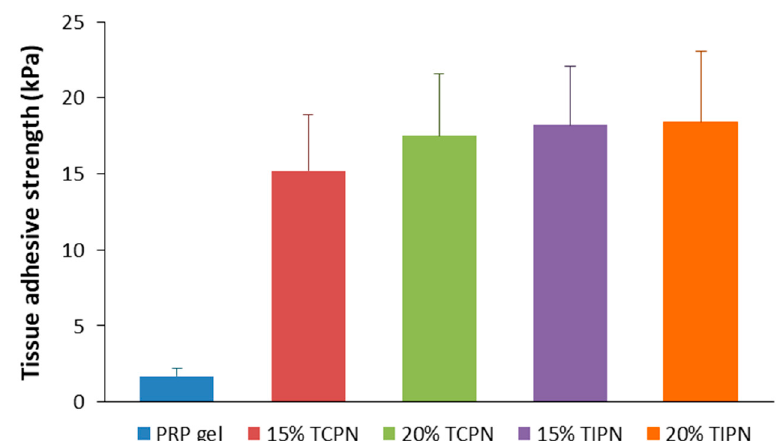
Figure 7. Tissue adhesive strength of PRP gel compared to hydrogel formulations of PRP at different triblock copolymer concentrations.